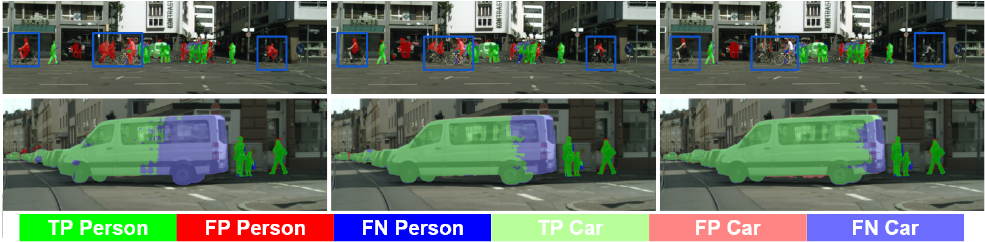
Figure 4. Analogous to Figure 3 for the classes Person and